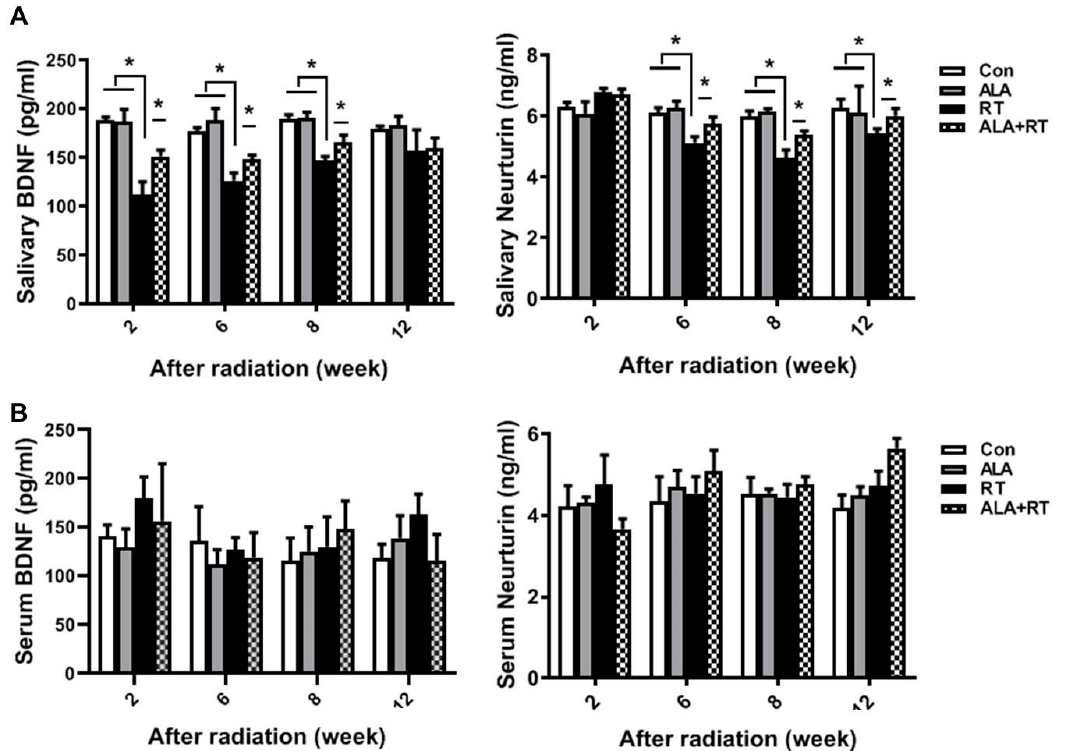
Figure 4. ALA maintains neurotrophic factor levels in SGs. Sprague–Dawley rats were subjected to 18 Gy irradiation in the head and neck region. SGs and serum were collected at each time points after irradiation and subjected to ELISA to measure BDNF (left in A and B) and neurturin (right in A and B) levels. N = 12–16 SGs/group. Values are represented as the mean ± SEM. * p < 0.05.